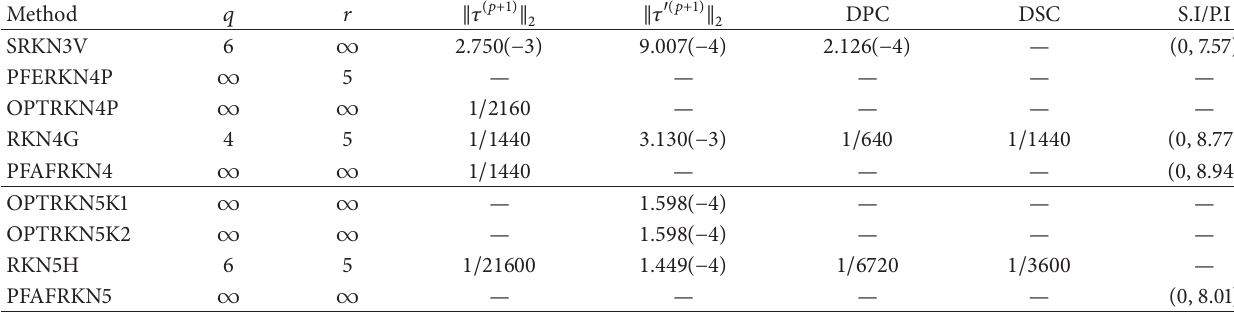
Table 1: Summary of the properties of the methods.